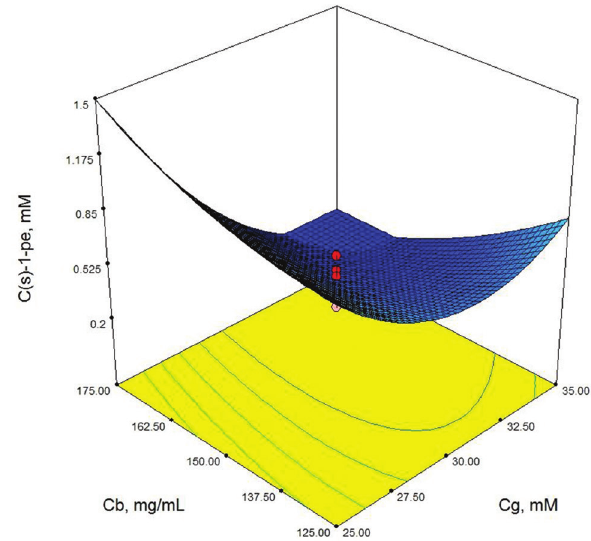
Figure 7: Contour-plot of ( S )-1-phenylethanol concentration: The effect of glucose concentration and biocatalyst concentration. = 150 mg/mL. Other variable is held at zero level. t=48 h, C b